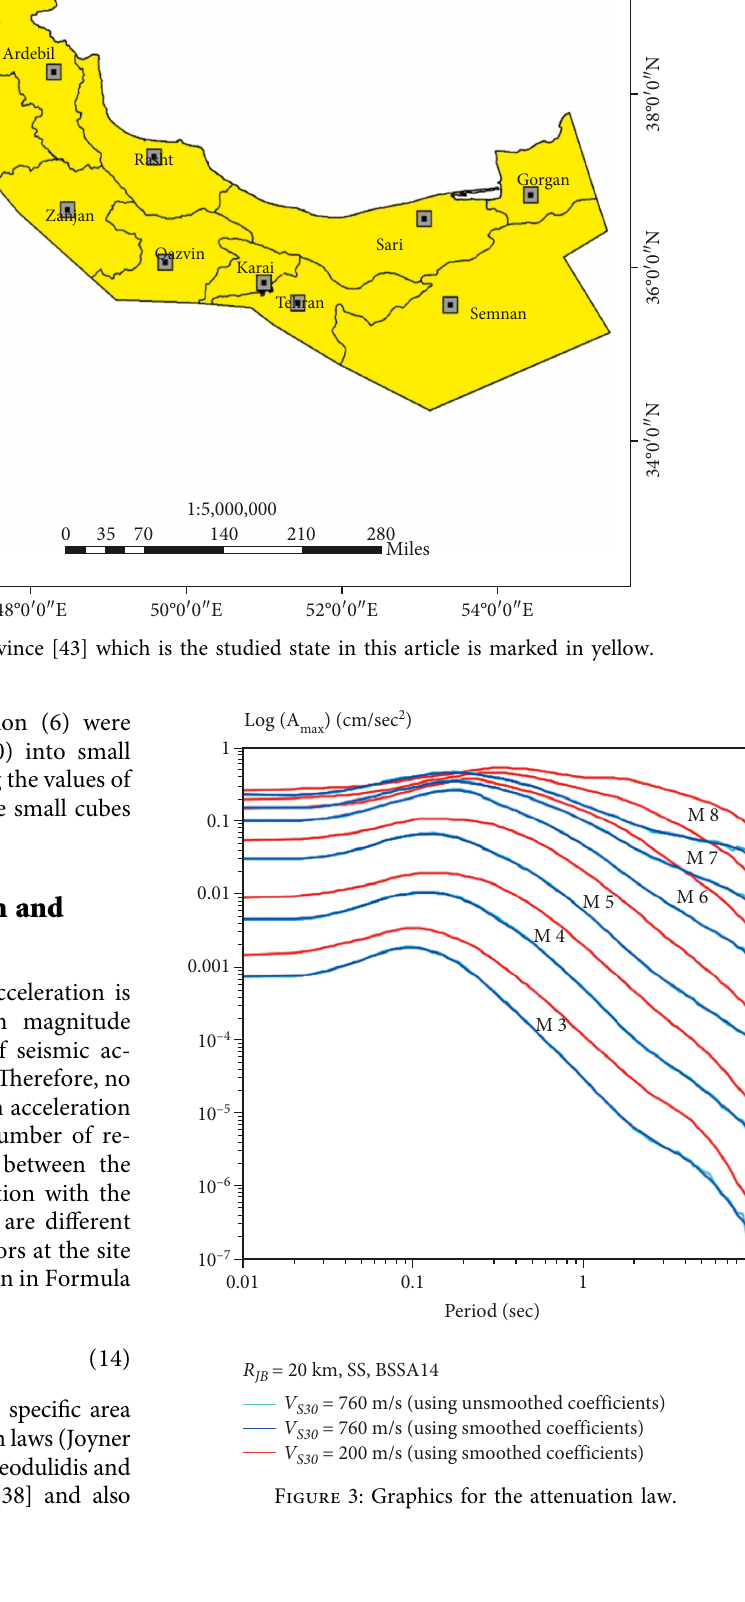
Figure 3: Graphics for the attenuation